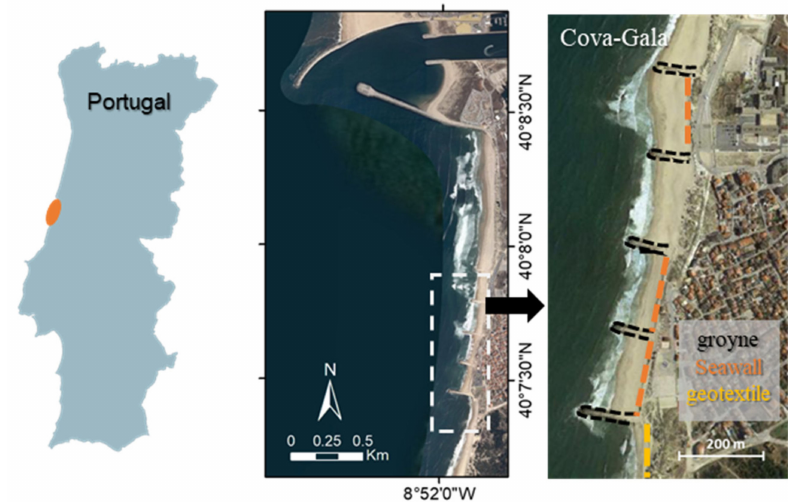
Figure 1. Satellite view of Cova-Gala and detail of the beach protection scheme: groyne field, seawalls, and geotextile tubes (Google Earth–3 August